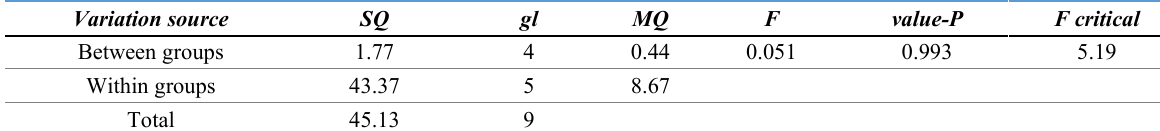
Table 9. ANOVA Phase 1 – the influence of the maximum aggregate size in RPC elasticity